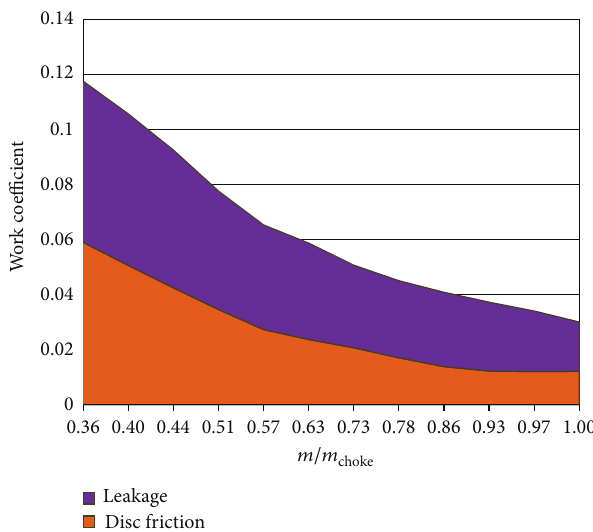
Figure 7: Distribution of work coefficient due to parasitic losses.